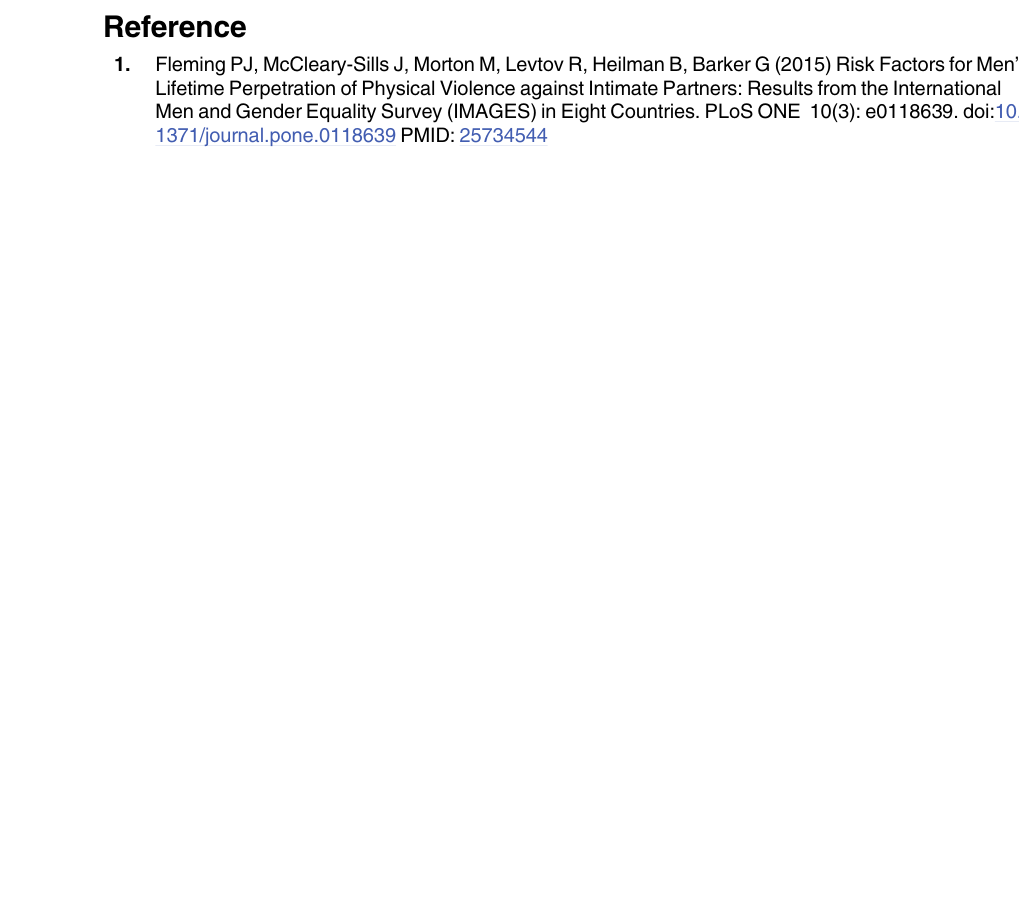
Men and Gender Equality Survey (IMAGES) in Eight Countries. PLoS ONE 10(3): e0118639. doi:10. 1371/journal.pone.0118639 PMID: